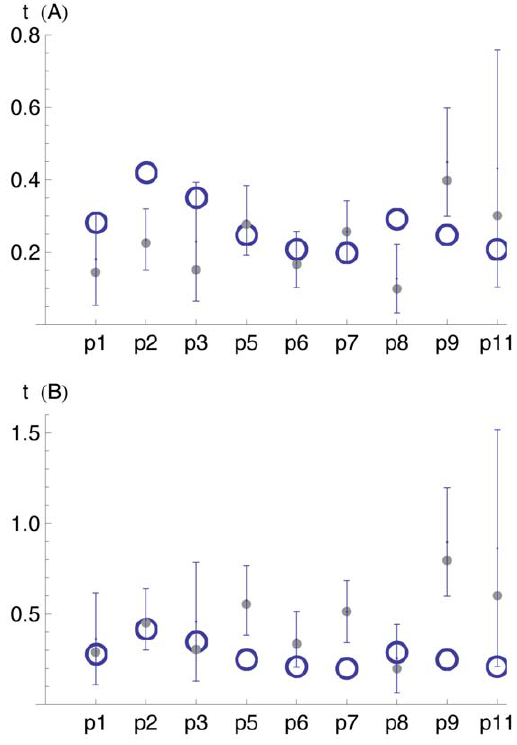
Figure 2. Comparison of two estimates of the seroconversion time for each of the nine patients. The effective generation time g in (A) and (B) are considered to be g ~ 1 day and g ~ 2 days, respectively. Maximum likelihood and 95% confidence interval estimates of the time of HIV seroconversion in years since the first HIV positive screening test are shown in full dots and error bars, respectively. Empty circles represent the mid-point estimates of the seroconversion times [46].